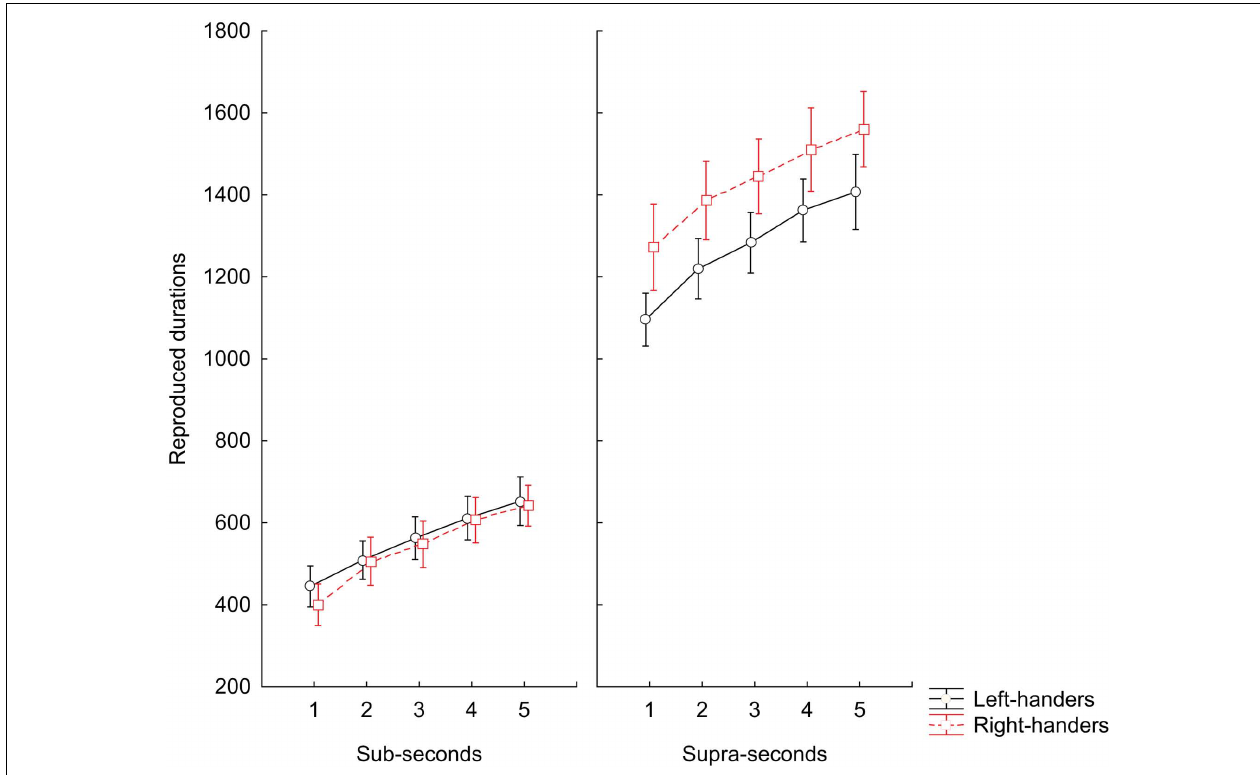
FIGURE 1 |Time reproduction task. Means of median RT values during reproduction of sub-second and supra-second intervals for left-handed subjects and right-handed subjects participants.The vertical bars indicate SE mean.